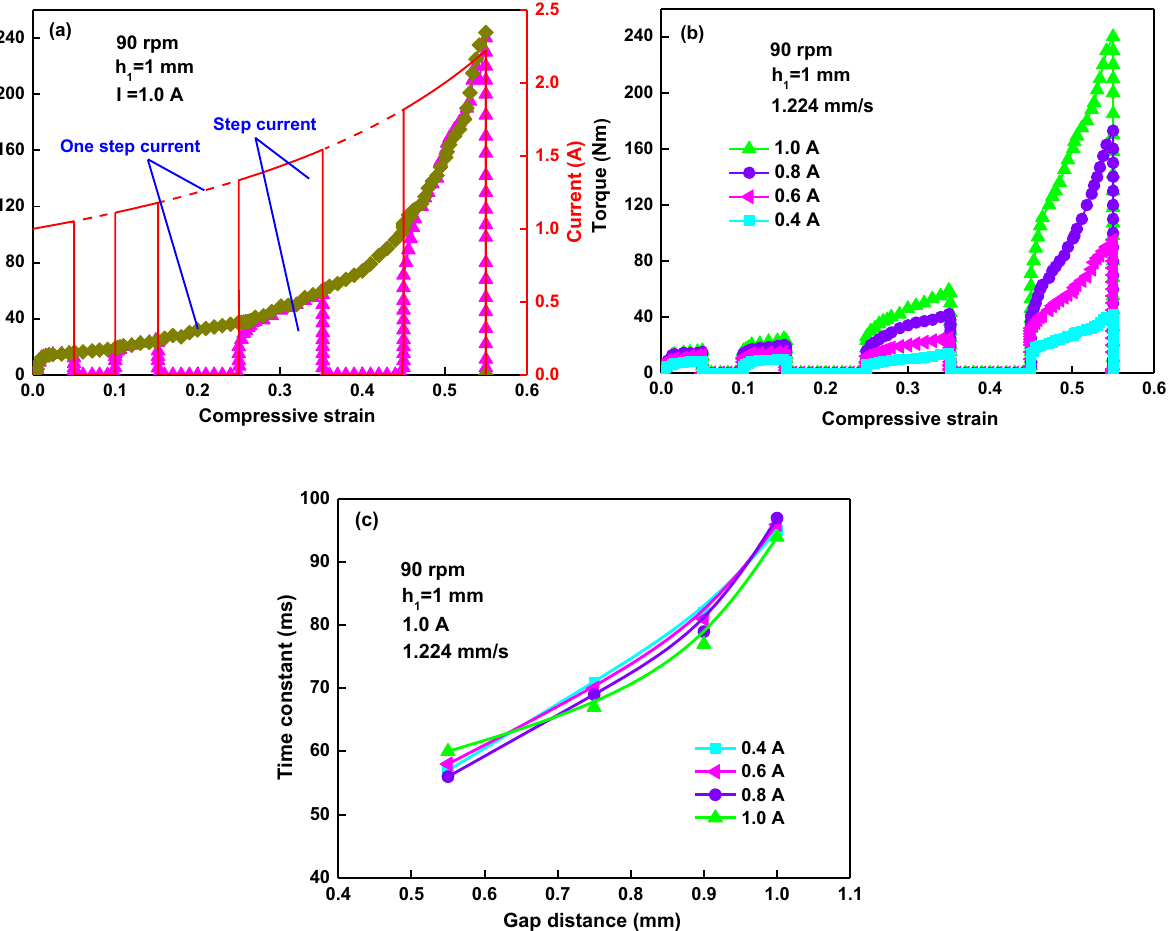
Figure 9. ( a ) Transient torque and instantaneous current versus compressive strain at a current of 1 A switched on/off between one and four times for the whole processes; ( b ) four test runs with four applied current that was switched on and off four times; ( c ) time constant versus gap distance under different applied